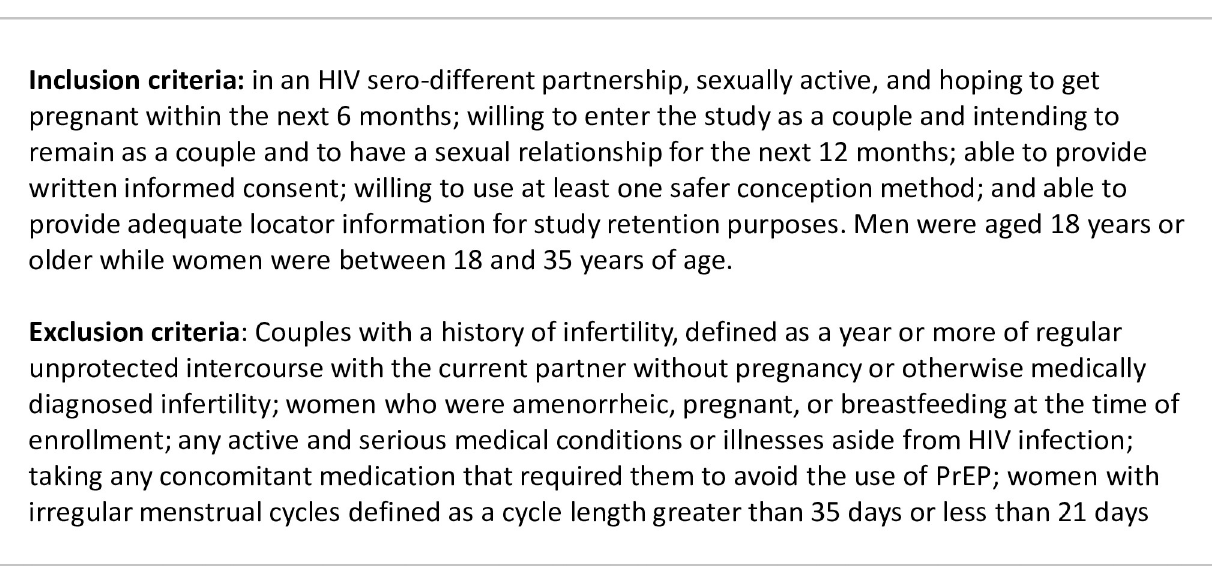
Fig 3. SAFER inclusion and exclusion